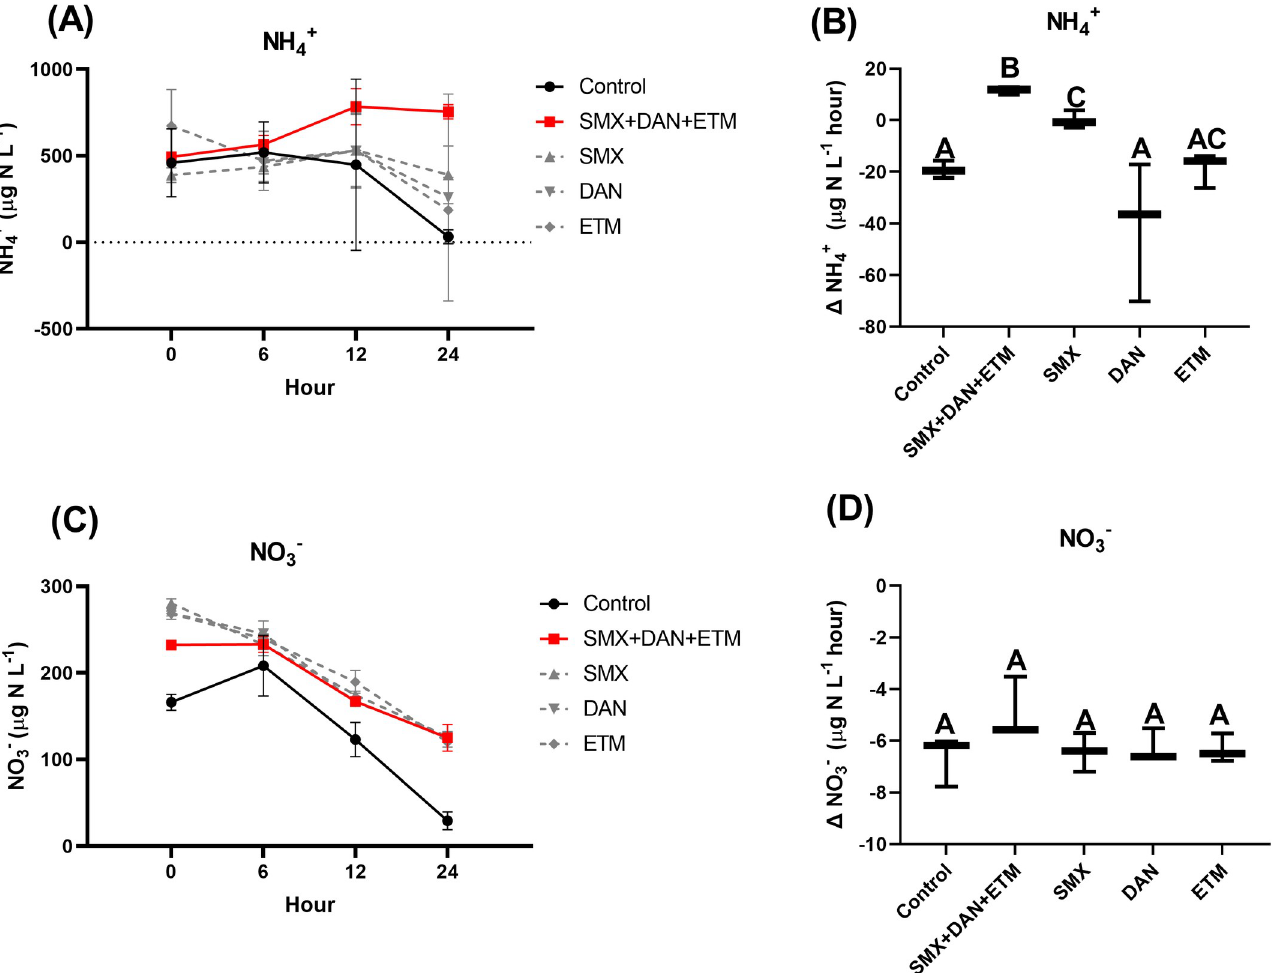
Fig 1. Mean ± SE dissolved (A) NH 4+ , (C) NO 3- concentrations in microcosms plotted across time (0,6,12, and 24 hour) and whisker plots (min to maximum) of the change in (B) NH 4+ and (D) NO 3- concentration from microcosms exposed to control and experimental treatments. Identical letters above bars (1B and 1D) indicate treatments that are not significantly different as determined by post hoc Pairwise Wilcox Test, while different letters indicate rates that are significantly different.